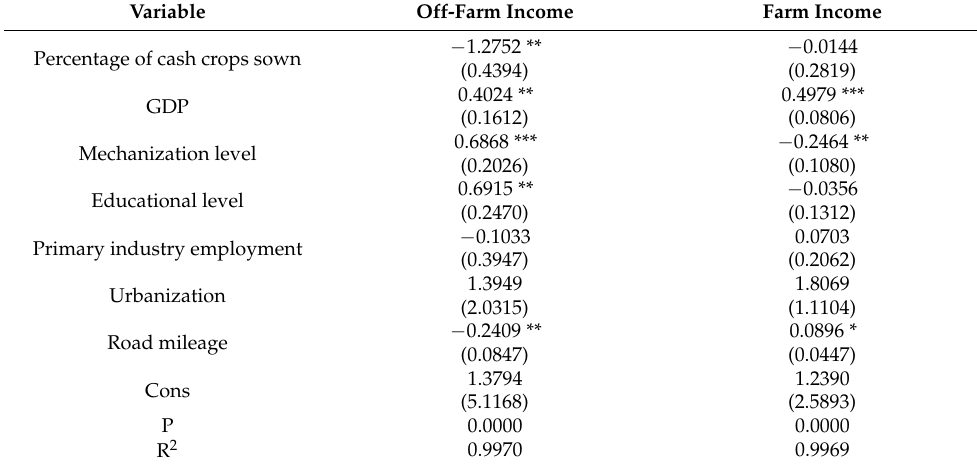
Table 2. Impact of non-food cultivation on non-farm income and farm